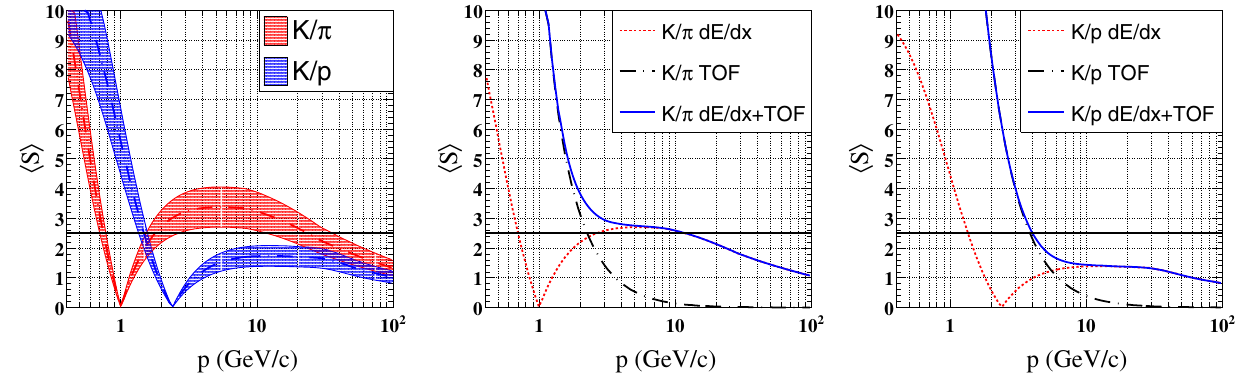
shown as dash-dotted lines. Middle and right: dE / dx (in the conserva- tive scenario) and/or TOF are used for K /π and K / p separation. The black solid line corresponds to 2.5 σ separation